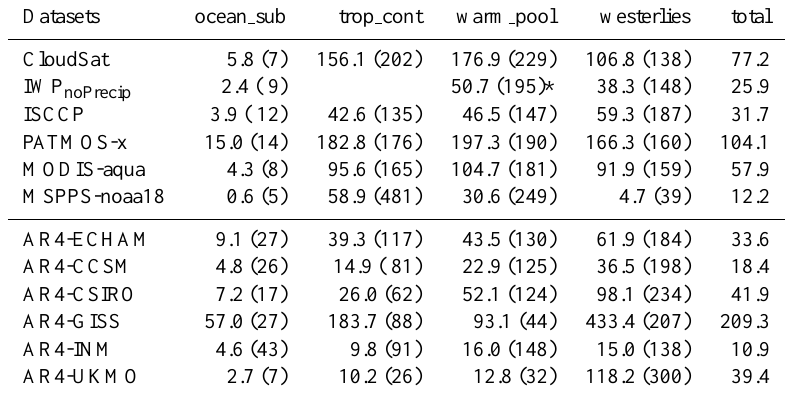
Table 5. Area-weighted mean IWP [g / m 2 ] for selected regions. The regional fraction IWP rel (in %), follows the regional mean in brackets. The mean IWP for the total region has been included in the table as a reference (far right). All available data have been used to retrieve the mean